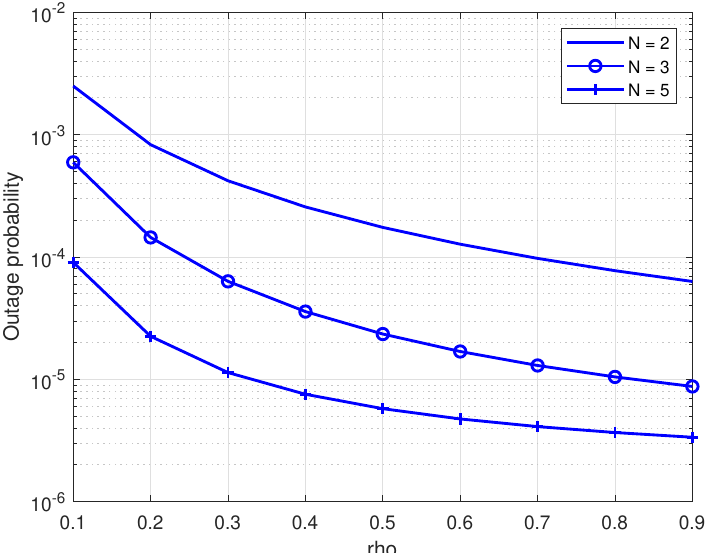
Figure 5. Outage probability versus power splitting ratio ( ¯ γ = 20 dB, Γ th = 5